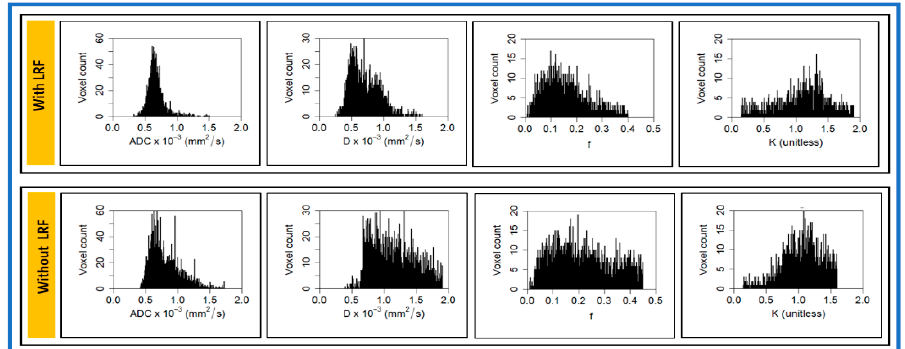
Figure 3. Representative voxel value distribution of apparent diffusion coefficient (ADC), true diffusion coefficient ( D ), perfusion fraction (f), and kurtosis coefficient ( K ) in patients with and without locoregional failure (LRF) of nasopharyngeal cancer (Figure 2). AD, D , and f values trended higher in a patient without LRF than compared with a patient with LRF. By contrast, K values trended higher in a patient with LRF compared with a patient without LRF. Histogram demonstrates distribution of each metric voxel value within ROI.